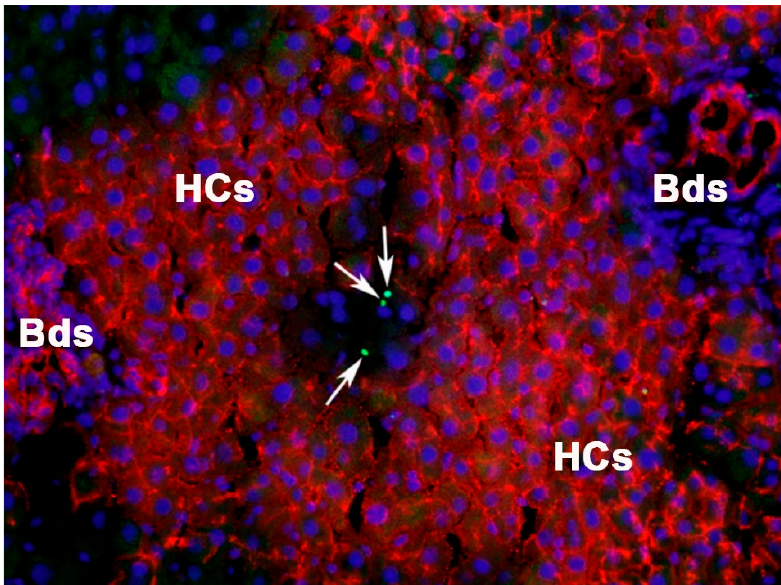
Figure 2. Apoptotic bodies in DPPIV − host hepatocytes being eliminated in a large coalescing cluster of transplanted DPPIV + FLSPCs. Simultaneous detection of transplanted (immunohistochemistry for DPPIV; red ) and apoptotic cells (TUNEL assay; green , highlighted by arrows). 4 ′ ,6-diamidino-2- phenylindole (DAPI) was used for staining of nuclei ( blue ). HCs: hepatocytes; Bds: bile ducts.